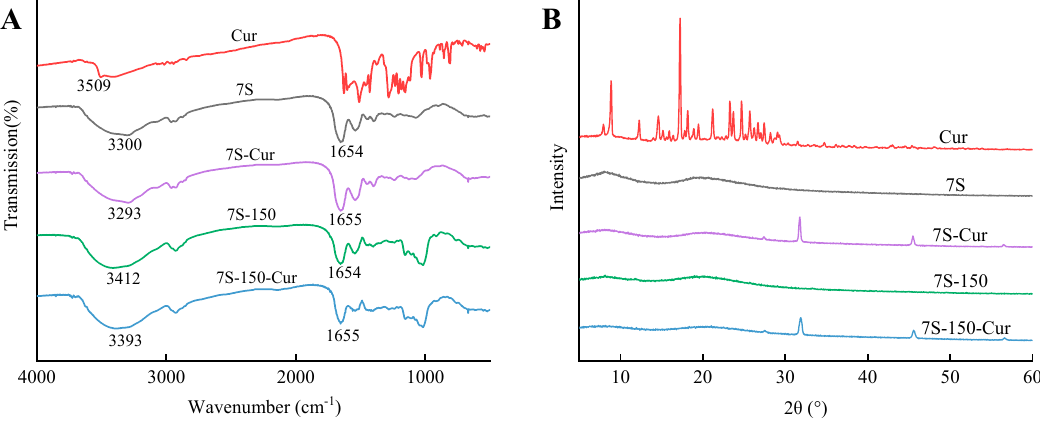
Figure 4. Fourier transform infrared (FTIR) spectra ( A ) and X-ray diffraction (XRD) patterns ( B ) of free curcumin, 7S, 7S-150, 7S-Cur, and 7S-150-Cur nanocomplexes. 7S: soy β -conglycinin; 150: dextran (150 kDa); Cur: